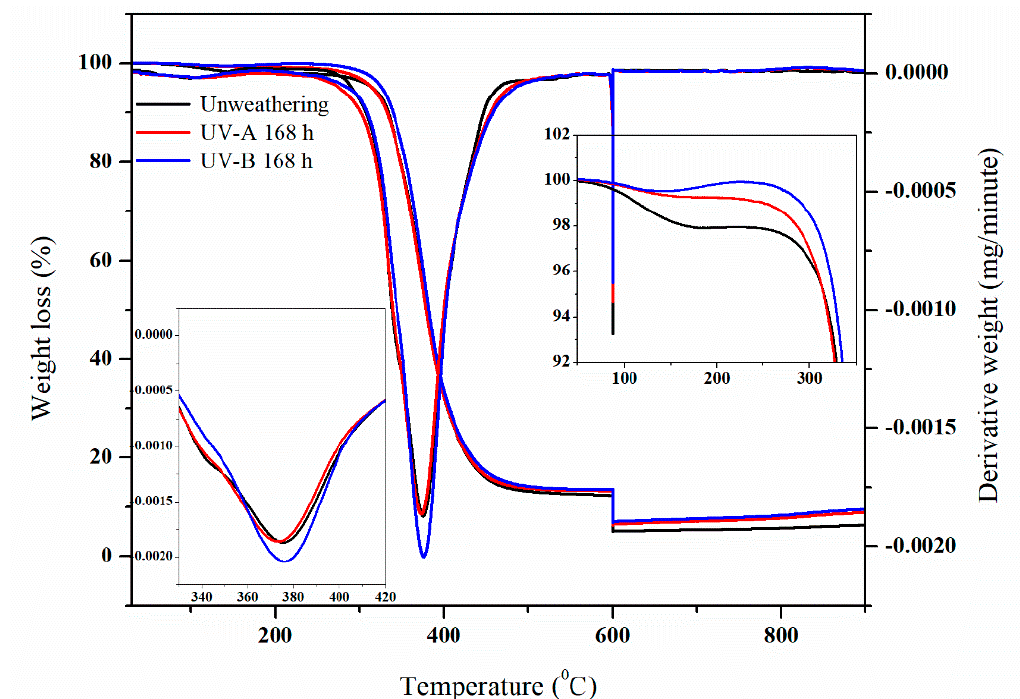
Figure 4. Thermogravimetric analysis (TGA) Thermogram of nanocomposites.